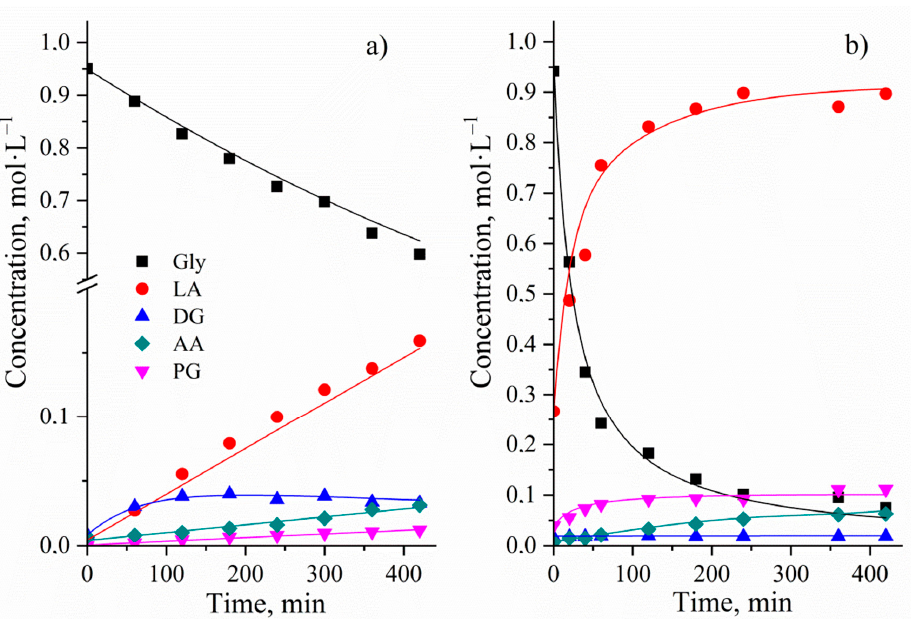
Figure 12. Experimental and calculated C/t-profile of the glycerol conversion without ( a ) and with Cu NPs catalyst ( b ). Reaction conditions: initial concentration of glycerol of 0.95 mol ∙ L –1 , reaction temperature of 513 K, stirring speed of 1000 rpm, NaOH/glycerol molar ratio of 1.1:1 ( a ) and glycerol/Cu molar ratio of 25.4:1, NaOH/glycerol molar ratio of 1.1:1 ( b ).